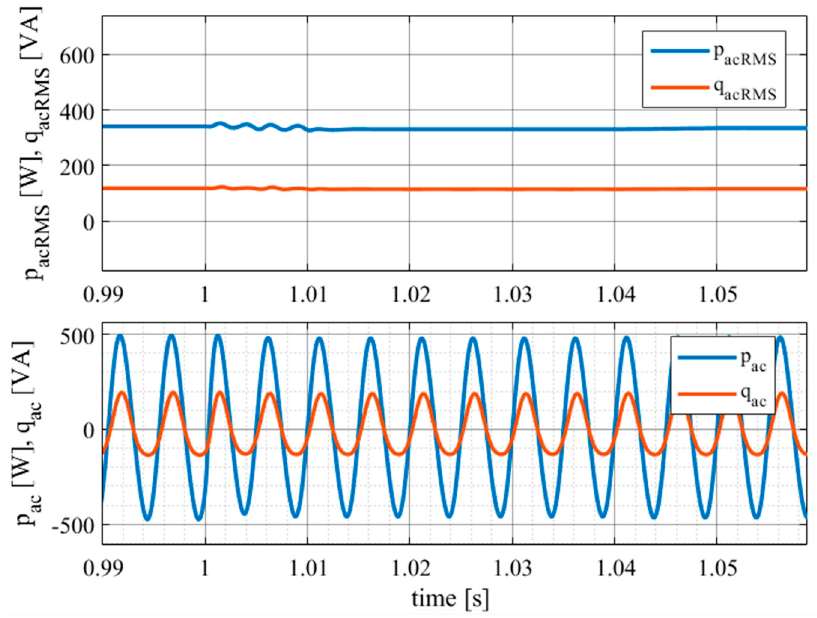
Figure 9. Time waveforms of 𝑝 (cid:3028)(cid:3030) , 𝑞 (cid:3028)(cid:3030) and 𝑃 (cid:3028)(cid:3030),(cid:3045)(cid:3040)(cid:3046) , 𝑄 (cid:3028)(cid:3030),(cid:3045)(cid:3040)(cid:3046) —case of compensating.